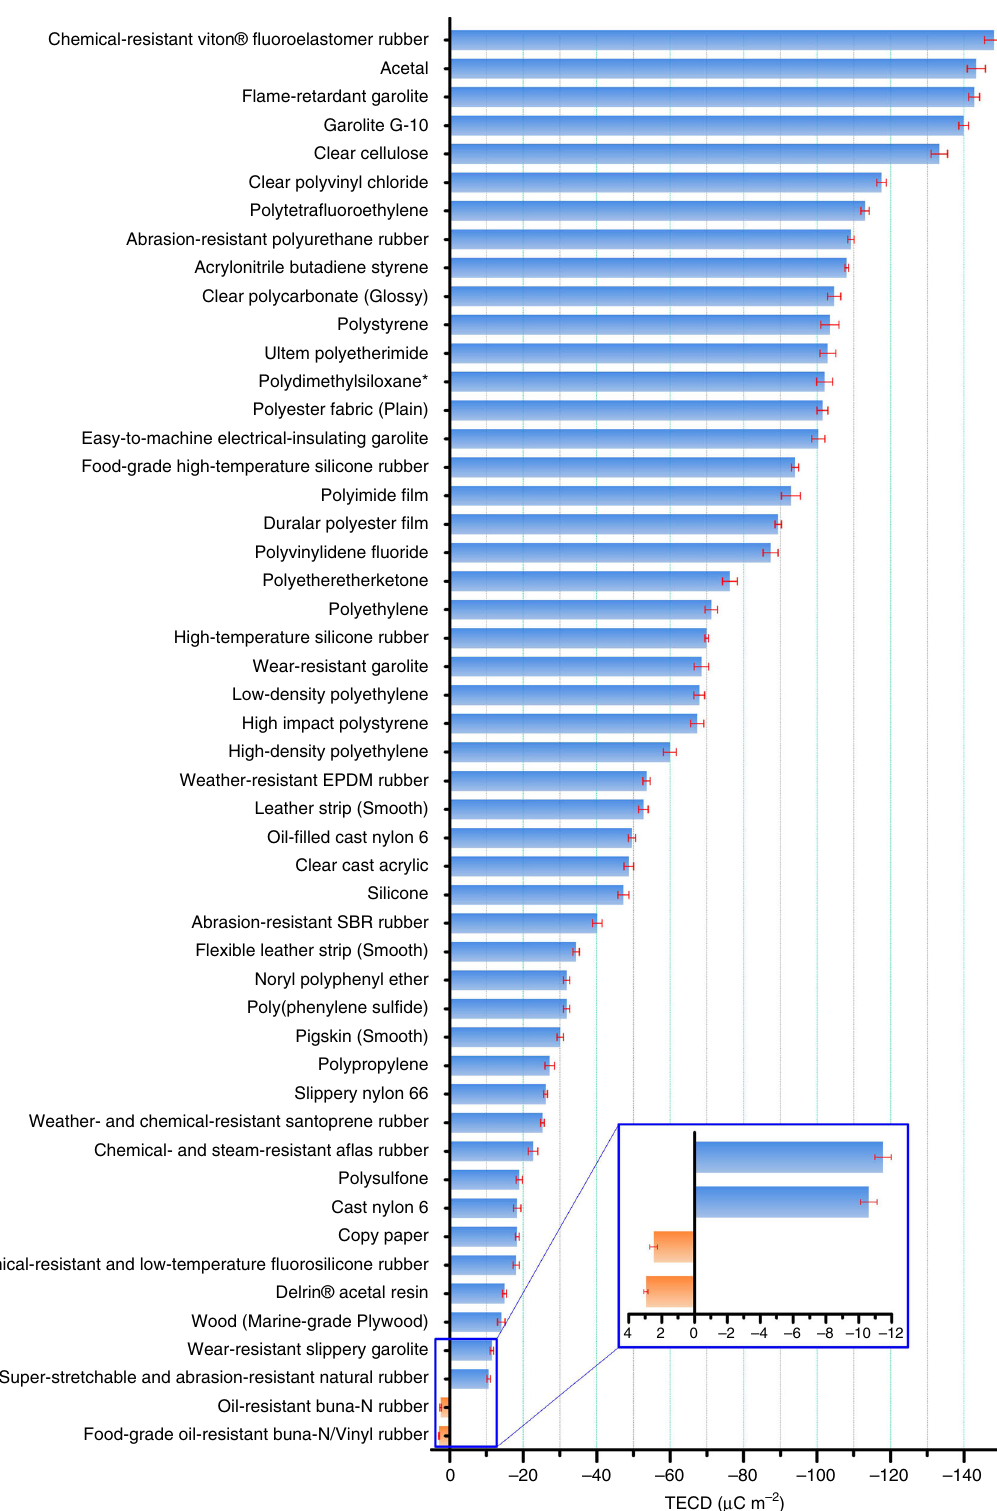
Fig. 4 The quanti fi ed triboelectric series. The error bar indicates the range within a standard deviation. Source data are provided as a Source Data fi